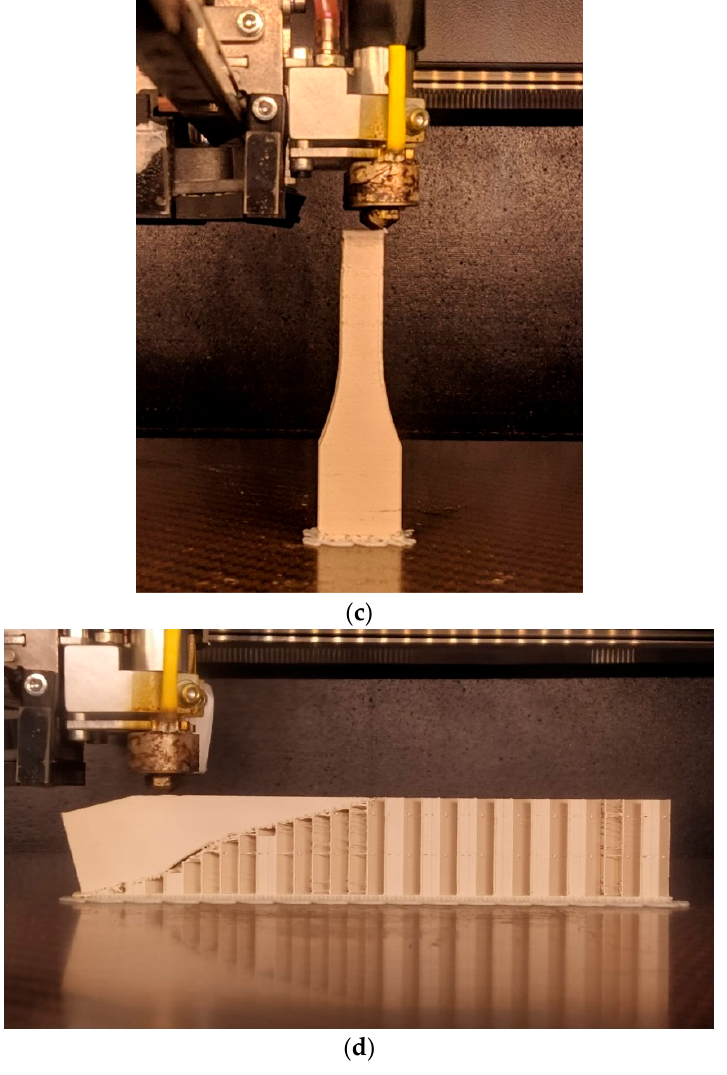
Figure 4. Manufacturing directions. ( a ) Flat configuration; ( b ) edge configuration; ( c ) vertical configuration; ( d ) 10° orientation.